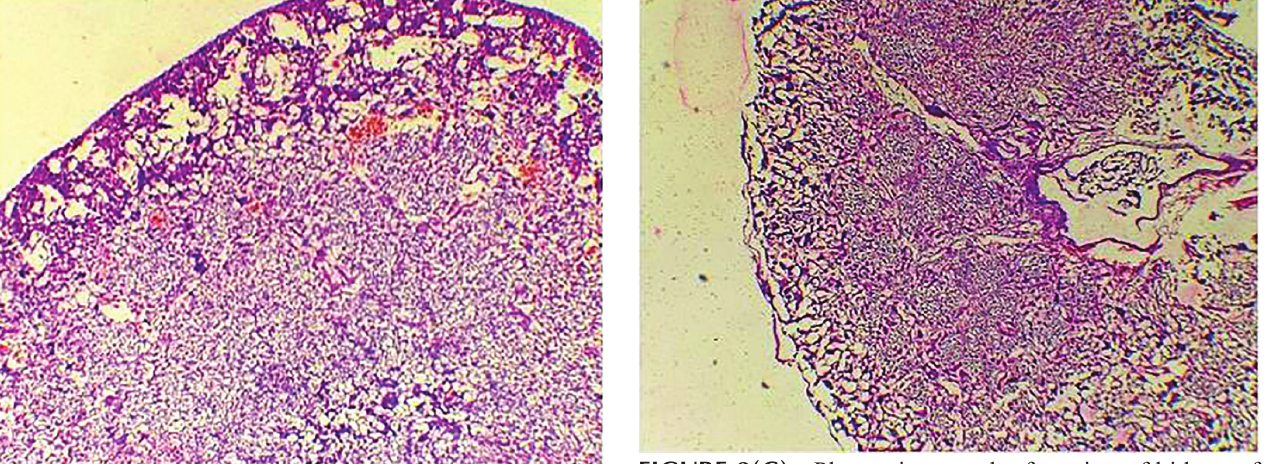
FIGURE 2(C) - Photomicrograph of section of kidney of neonate of pregnant rat exposed to pesticide glyphoshate shows degenerative changes and vacuolization. (H & E 40X).